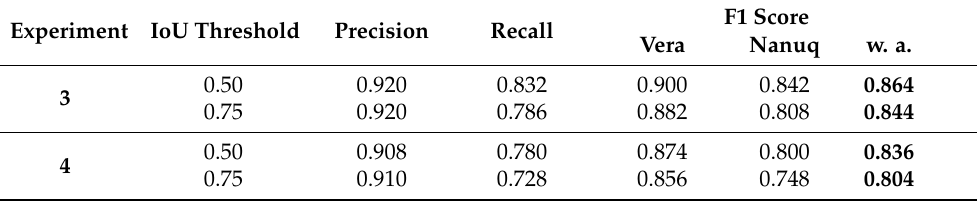
Table 5. Experiment 3 investigated the performance when using yolo for detecting the animals and ResNet18 for classifying them. Experiment 4 assessed the possibility of using yolo for both object detection and classification. For both experiments we evaluated precision, recall and resulting F1 scores at different thresholds for the IoU. The scores are given for both individual animals as well as the weighted average